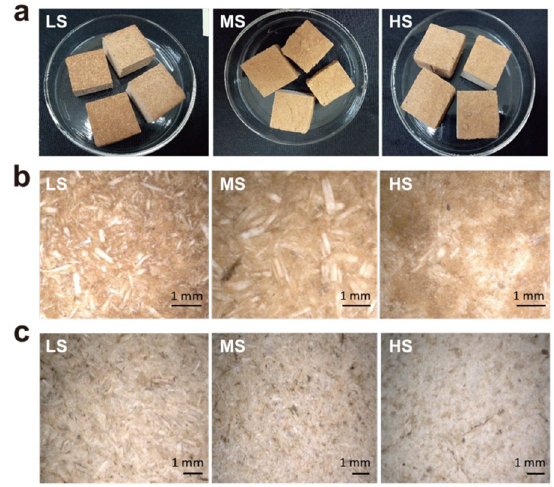
Fig. 1 Whole view ( a ) and magnified horizontal ( b ) and vertical ( c ) surfaces of artificial diets used in this study. LS, low-starch content diet. MS, medium-starch content diet. HS, high-starch content